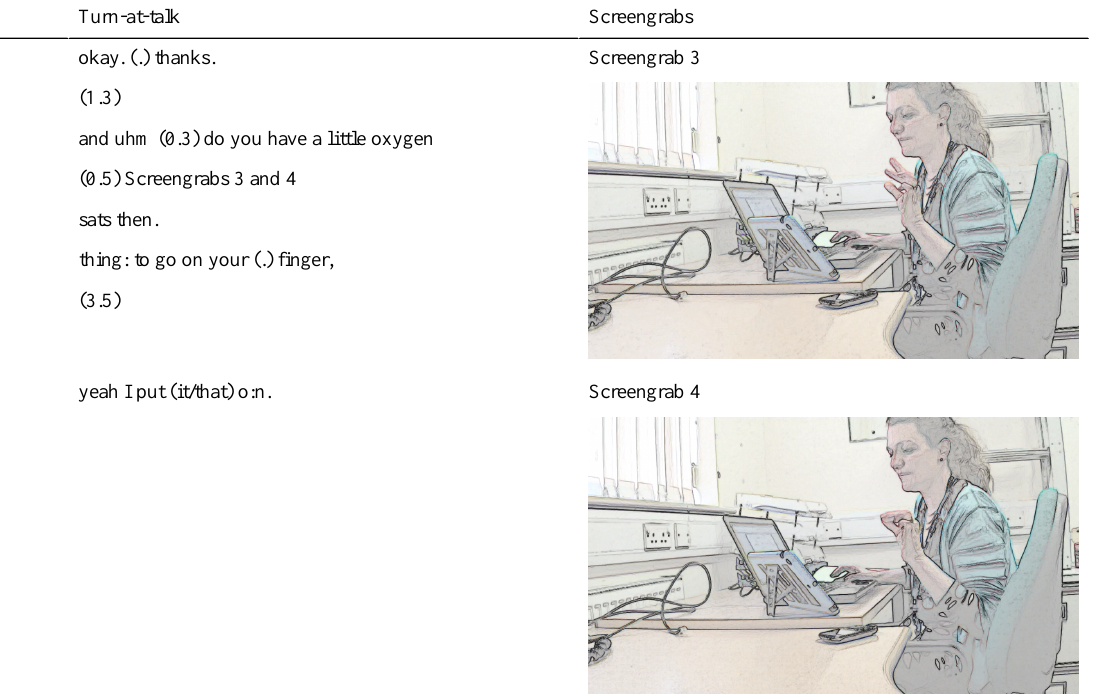
Table 2. Example of a heart failure specialist nurse explaining the use of an oximeter to a patient (data recorded at the clinic end). ScreengrabsTurn-at-talkSpeaker